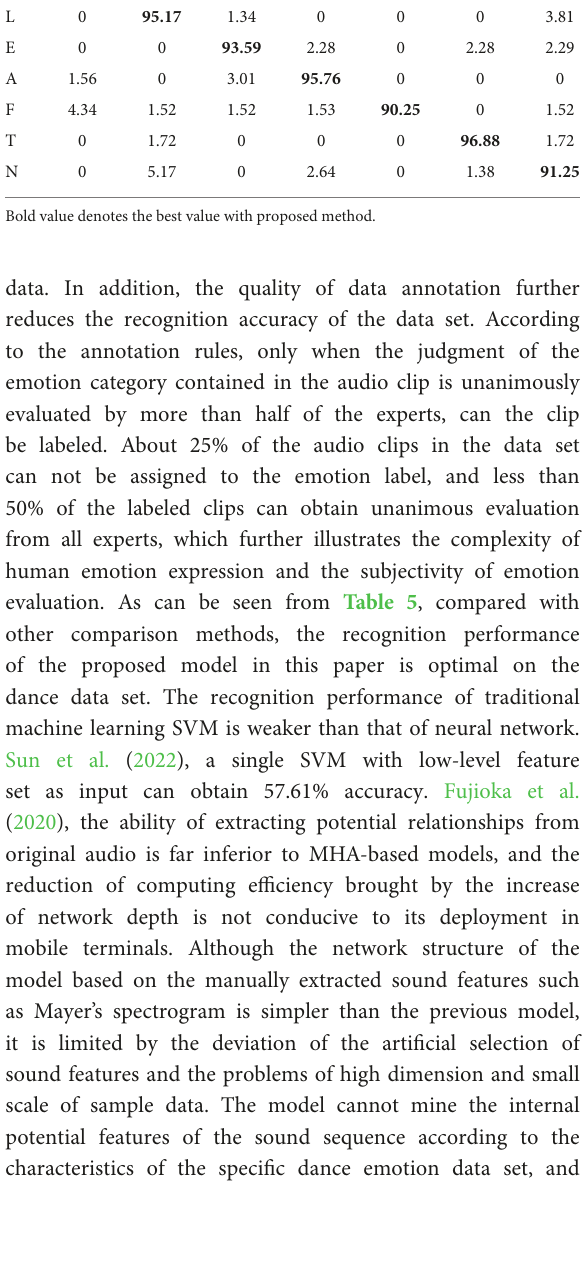
FIGURE4 Line graph of SA-Bi-LSTM.